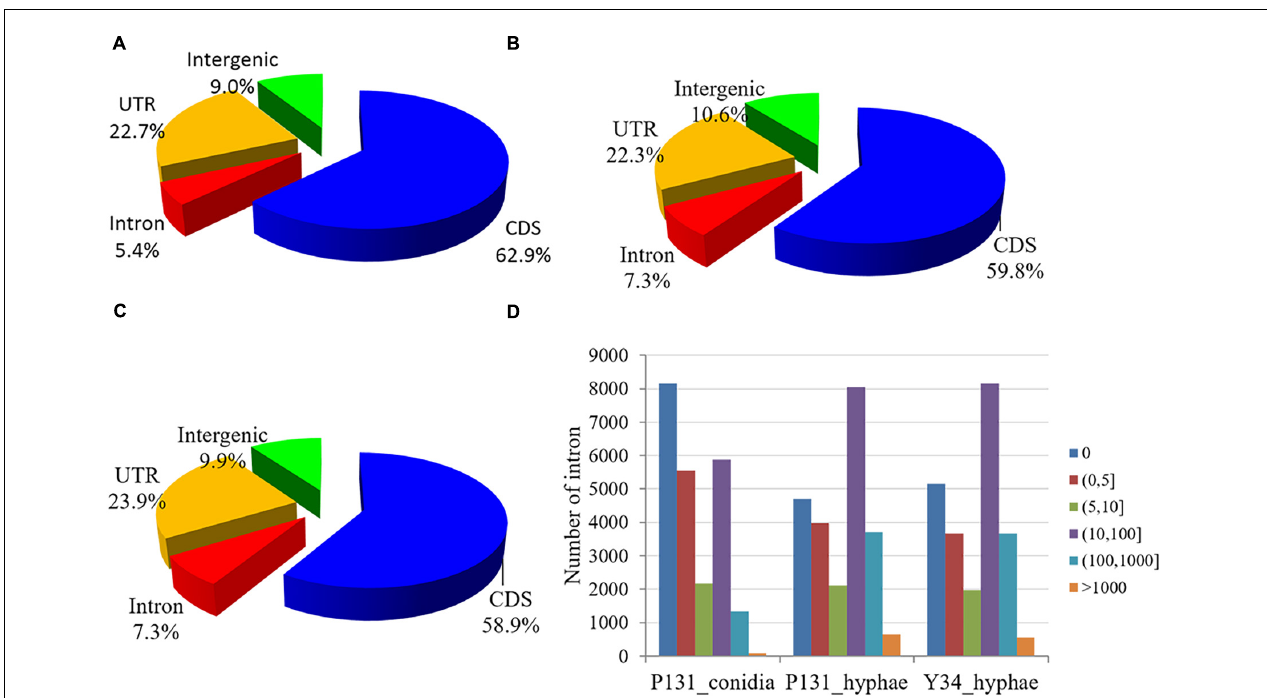
FIGURE 1 | Read distribution in the genome. (A–C) Pie charts showing reads from the RNA-Seq data of P131_conidia (A) , P131_hyphae (B) , and Y34_hyphae (C) that mapped to the coding region (CDS), 5 (cid:48) - or 3 (cid:48) -untranslated regions (UTR), introns, and intergenic regions. (D) Read counts mapped onto the introns. Bins denote different groups of read counts. The Y-axis shows the number of introns. genes ( Table 1 ). RNA-Seq data showed that at least 66% of the P. oryzae genome were expressed in hyphae and conidia, which was more than 54% of the MG8 annotation.